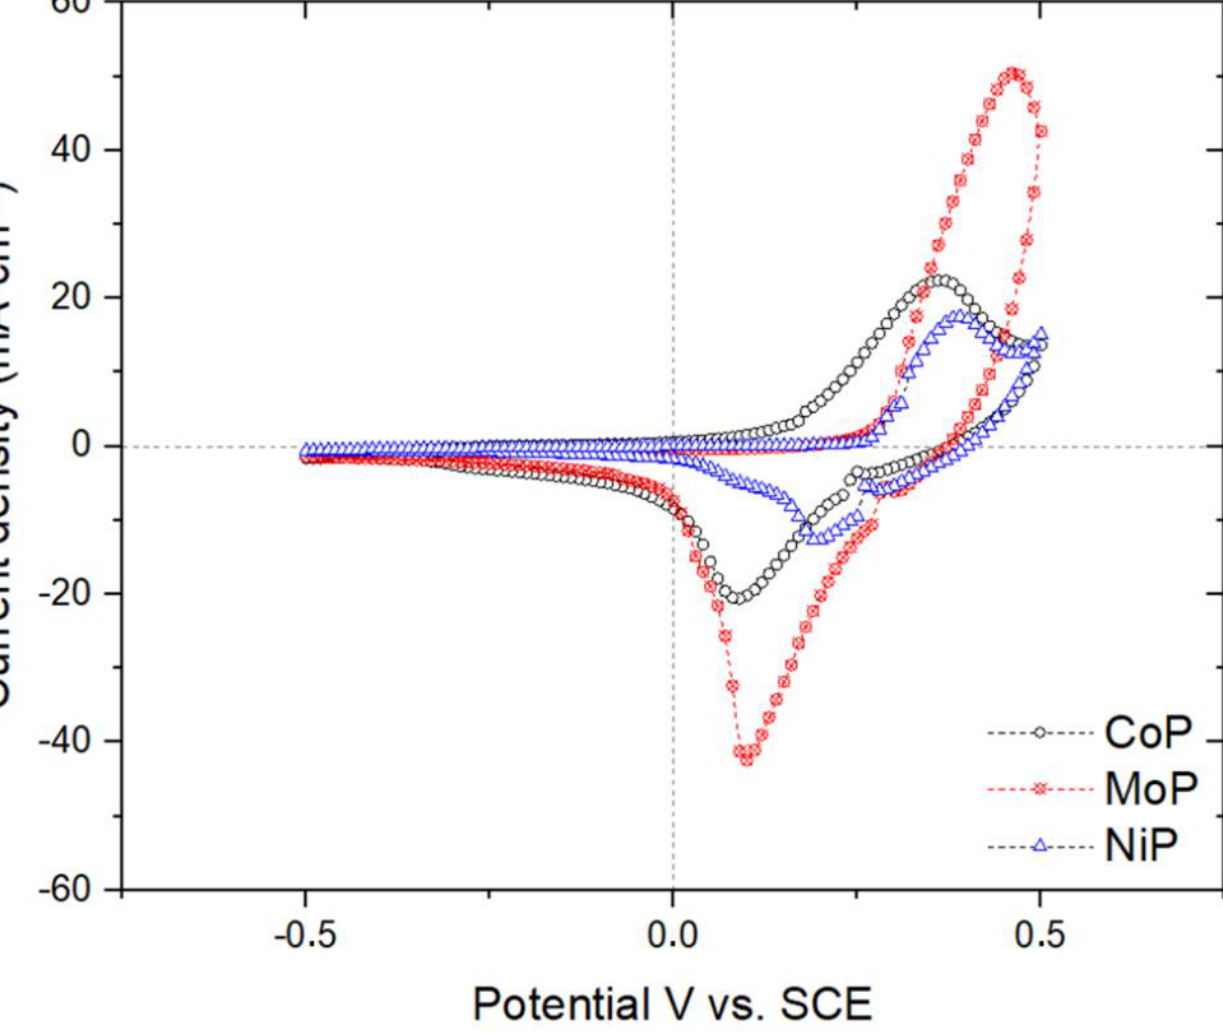
Figure 6. CV representation for CoP, MoP, and NiP.